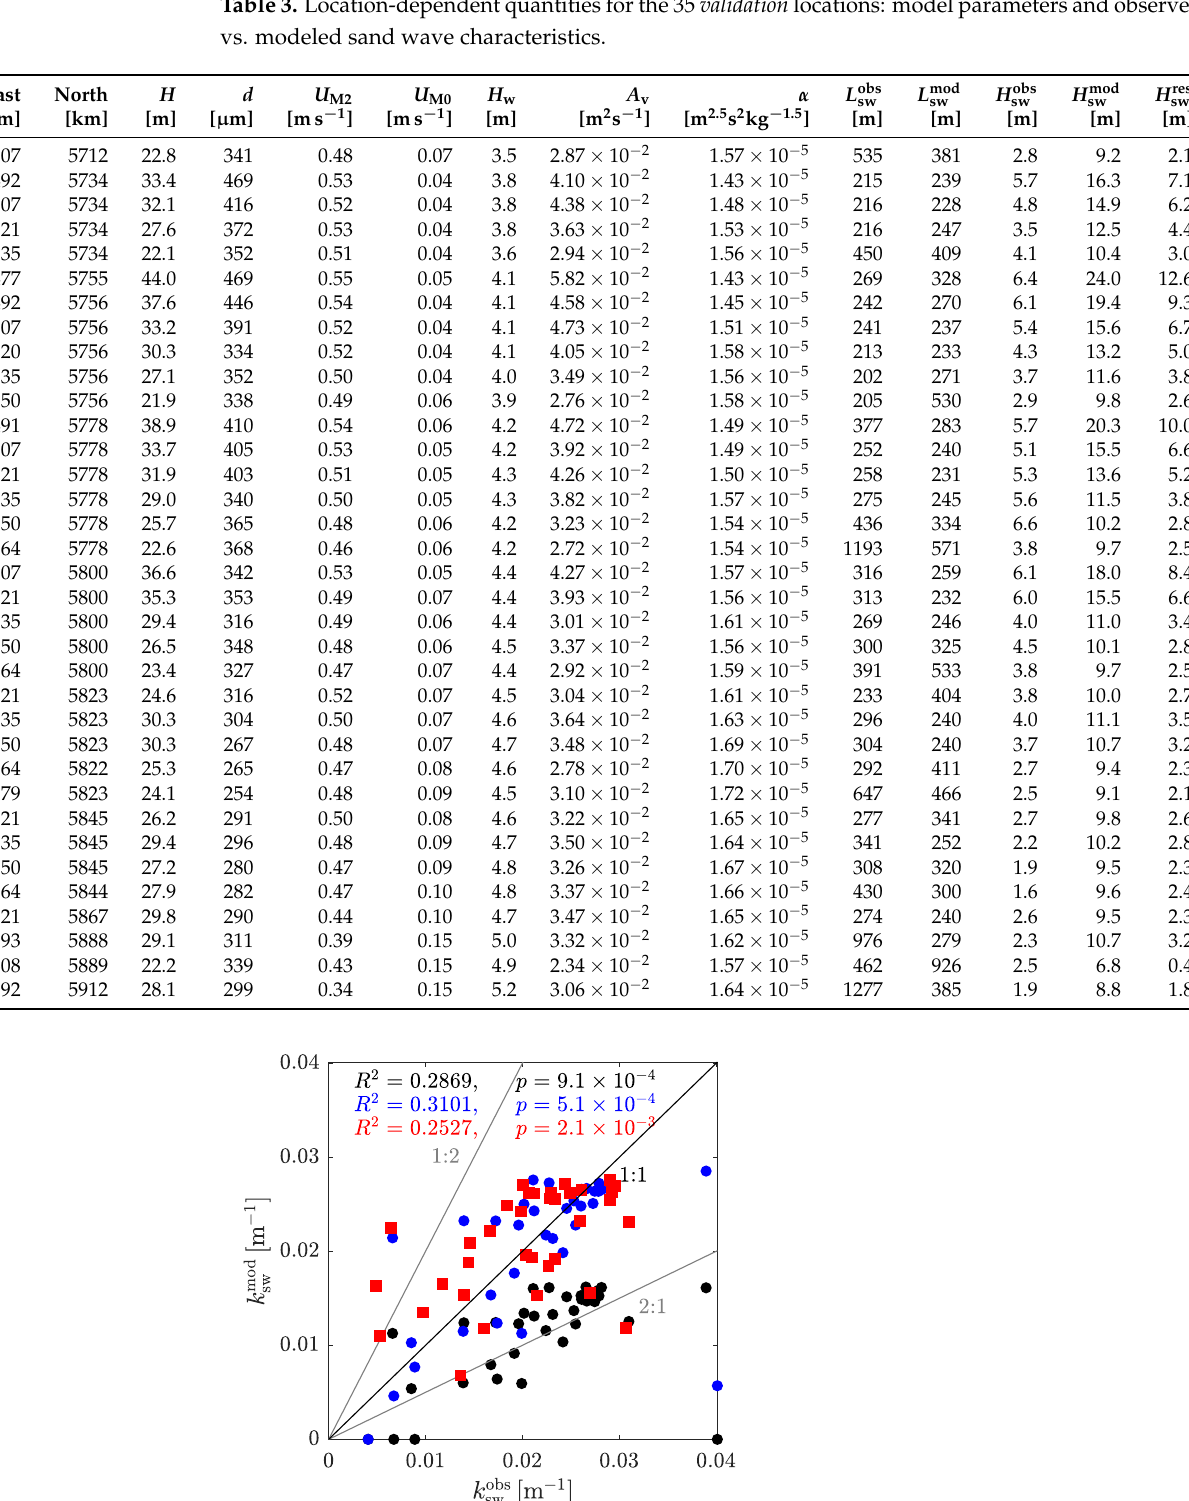
Figure 7. Observed versus modeled topographic wave numbers for the calibration locations (blue circles) and validation locations (red squares). The black circles correspond to the calibration loca- tions, using uncalibrated values ( S = 0.01m/s and T w = 6s) as adopted by Campmans et al. [19]. For comparison, the 1:1, 2:1, and 1:2 lines are shown and the correlation coefficients R and p-values between the observed and modeled sand wave wavenumbers are